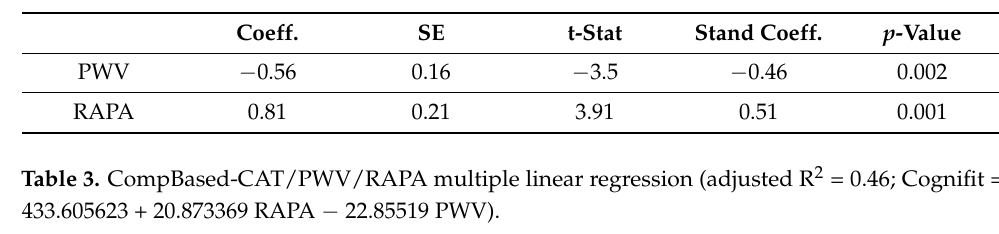
Table 2. MOCA/PWV/RAPA multiple linear regression (adjusted R 2 = 0.66; MOCA = 28.892 − 0.563 PWV + 0.810 RAPA).